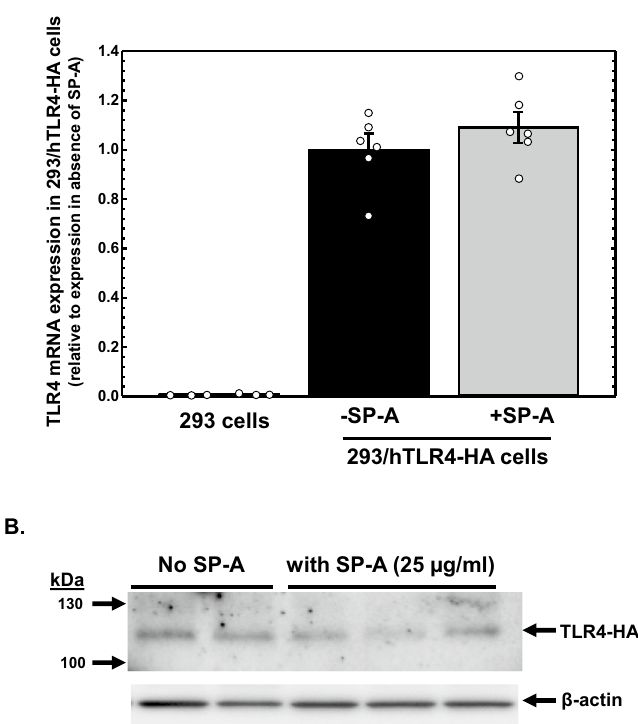
Figure 5. Impact of SP-A exposure on TLR4 mRNA and protein levels in 293/hTLR4-HA cells. ( A ) Real- time quantitative RT-PCR analysis of TLR4 mRNA in HEK293 cells (that do not express TLR4) and in 293/ hTLR4-HA cells that express HA-tagged TLR4 via an expression cassette, incubated in the absence or presence of SP-A (25 µg/ml) for 24 h. Shown are the levels of TLR4 mRNA relative to untreated 293/hTLR4-HA cells (n = 6 from 2 assays). ( B ) Western analysis of HA-tagged TLR4protein expressed from 293/hTLR4-HA cells incubated in the absence or presence of SP-A (25 µg/ml) for 24 h. Shown are the results of western analysis using antibodies specific for HA and β-actin following PAGE of cellular protein. Figure created using SigmaPlot, ver 14, www.systa tsoft